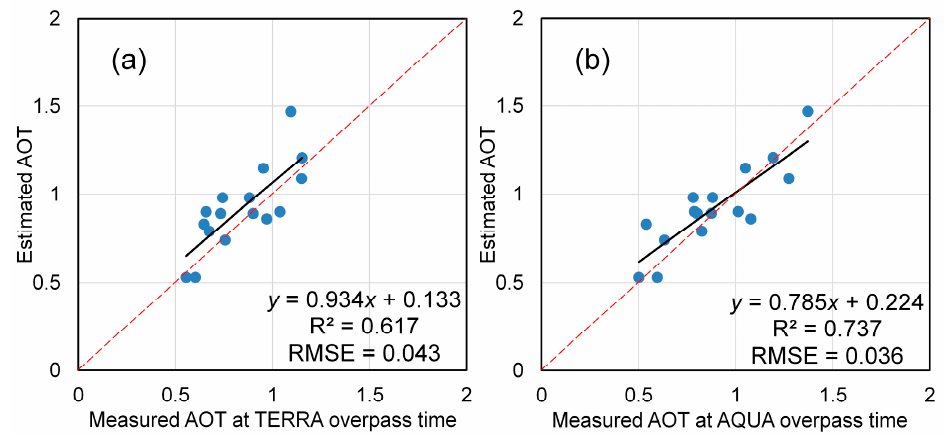
Figure 5. Comparisons of the TERRA-AQUA aerosol retrievals and the sun photometer aerosol measurements at ( a ) the TERRA overpass time and ( b ) the AQUA overpass time.